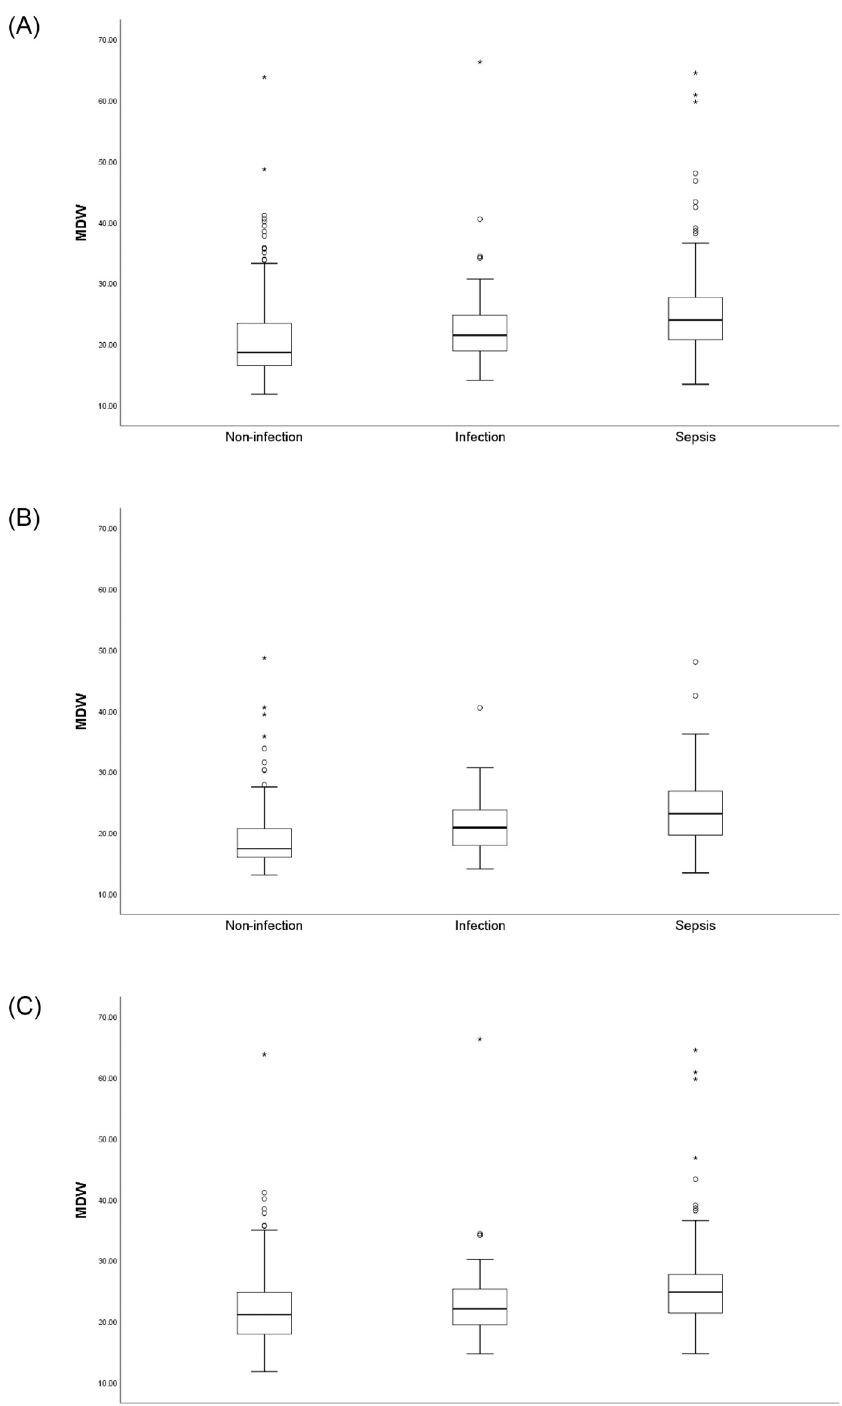
Fig 2. Comparison of MDW among groups with different immune statuses according to Sepsis-3 definition. (A) All patients. (B) Immune-competent patients. (C) Immune-compromised patients. MDW, monocyte distribution